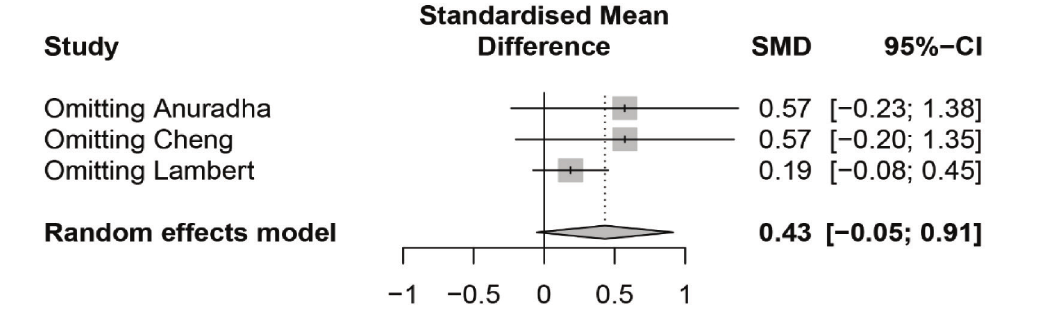
Figure 5. Meta-analysis of the effects of calcium supplement and placebo on the whole-body BMD in healthy children after exclusion of articles one by